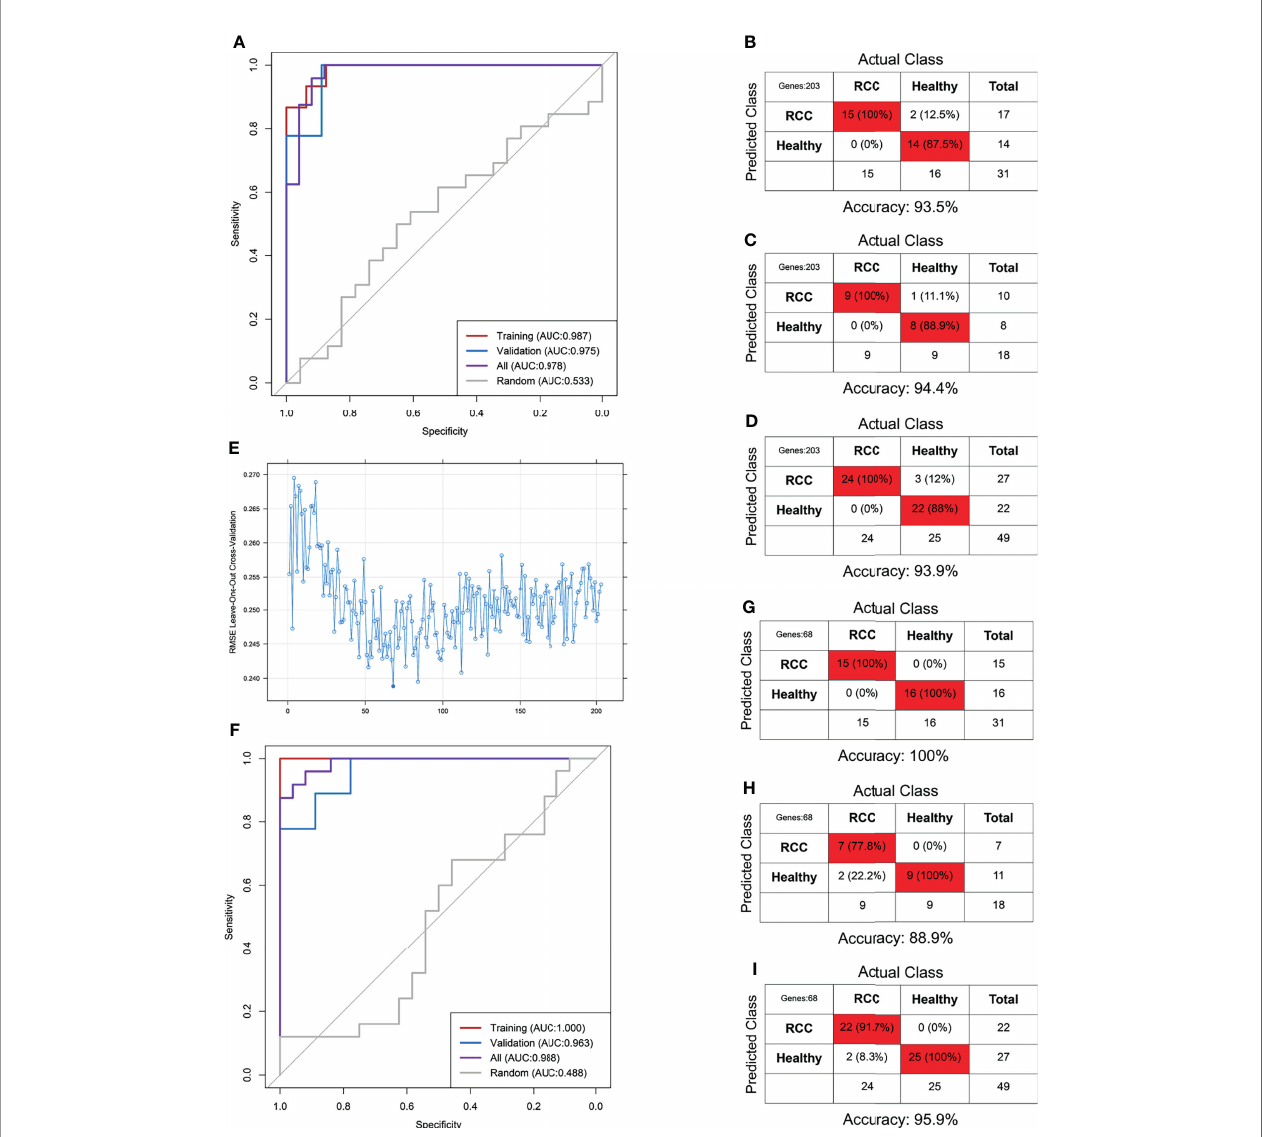
FIGURE 5 | The RCC-based TEP model for the detection of RCC. The ROC curve (A) and the confounding matrix in the training set (B) , validation set (C) , and overall cohort (D) of the primary model. The ROC curve (F) and the confounding matrix in the training set (G) , validation set (H) , and overall cohort (I) of the optimized model after REF selection (E)